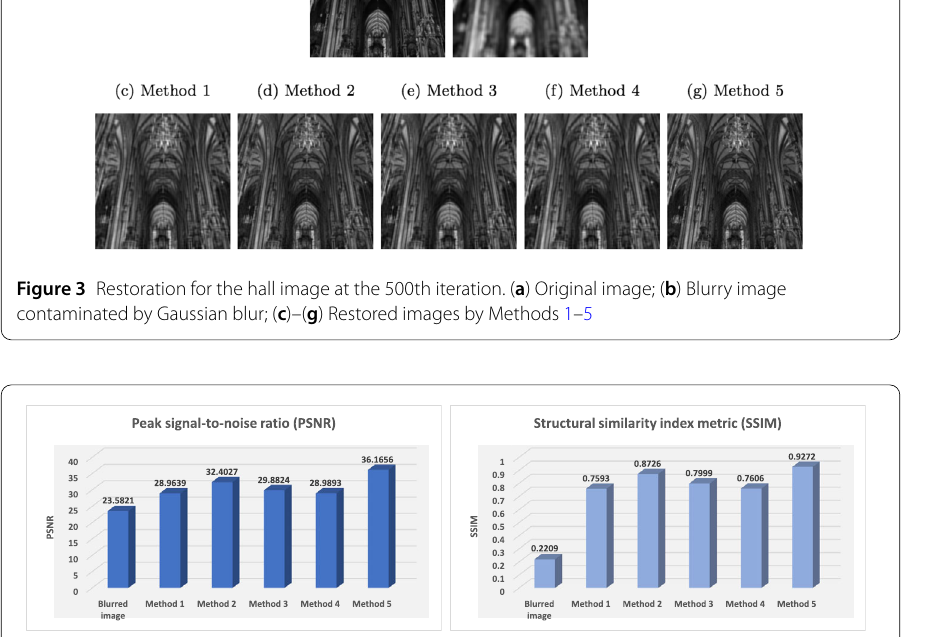
Figure 4 The comparison of PSNR and SSIM values for the blurred image and restored images by Methods 1–5 at the 500th